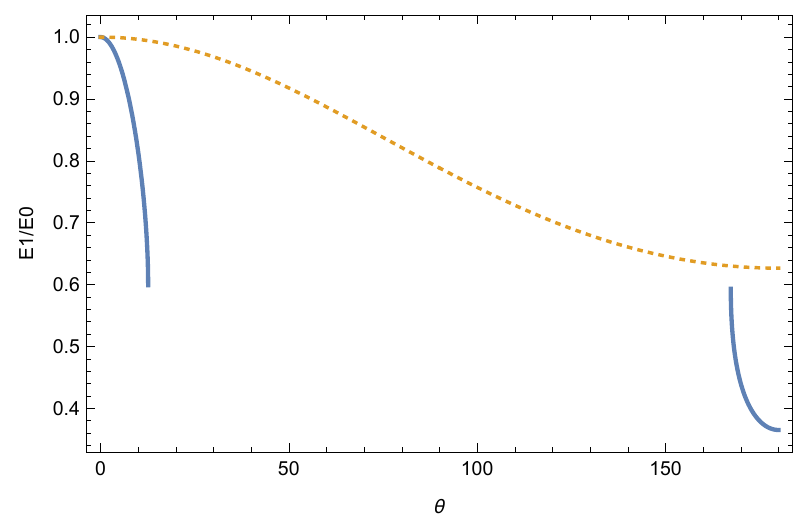
Figure 3. Kinematical factor for 41 a monopole whose mass is taken to be 10 m 41